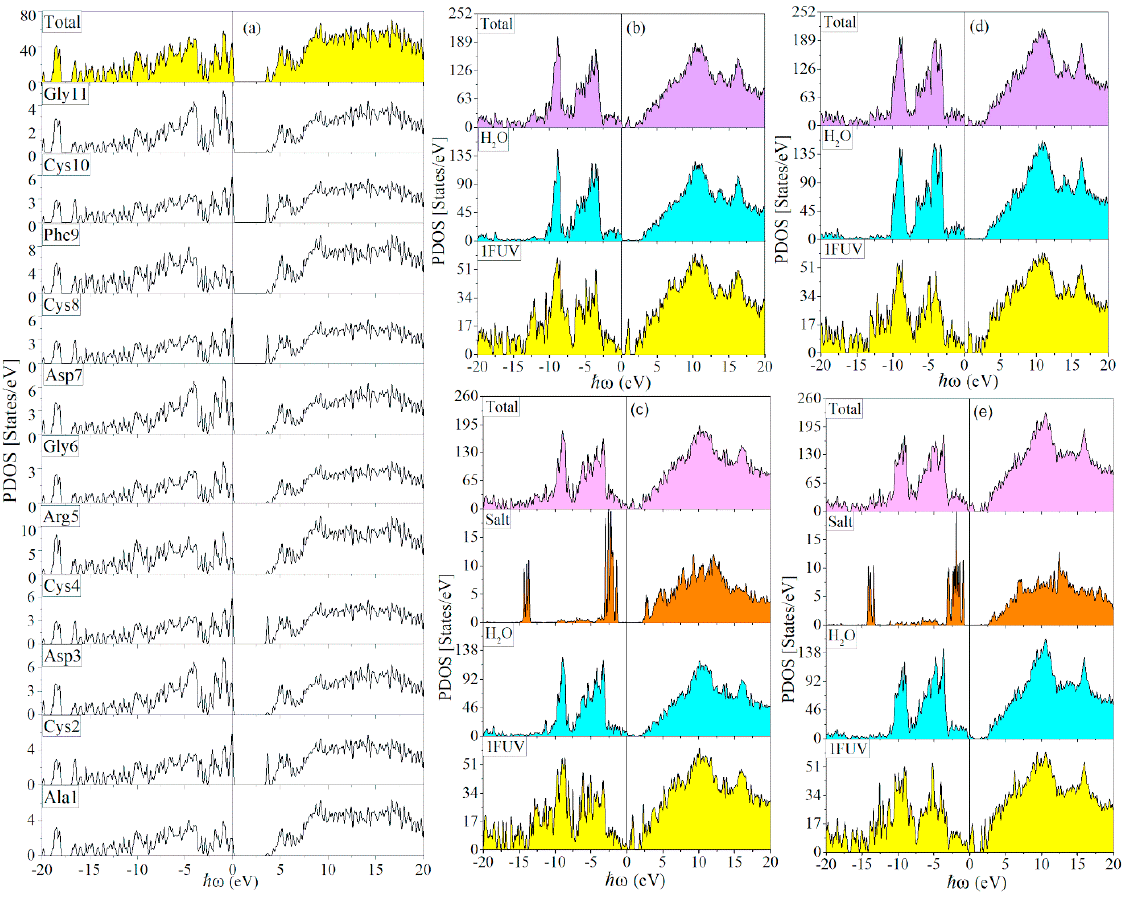
Figure 2. DOS and PDOS of 5 models for 1FUV: ( a ) Dry model further resolved for each amino acid in a separate panel; ( b ) with 80 water molecules resolved into 1FUV and 80 H 2 O; ( c ) with 80 H 2 O molecules, and 4 Na and 3 Cl ions resolved into 1FUV, 80 H 2 O, and 0.15 NaCl ( d ) with 100 water molecules resolved similar to ( b , e ) with 100 H 2 O molecules, and 0.15 NaCl resolved similar to ( c ).